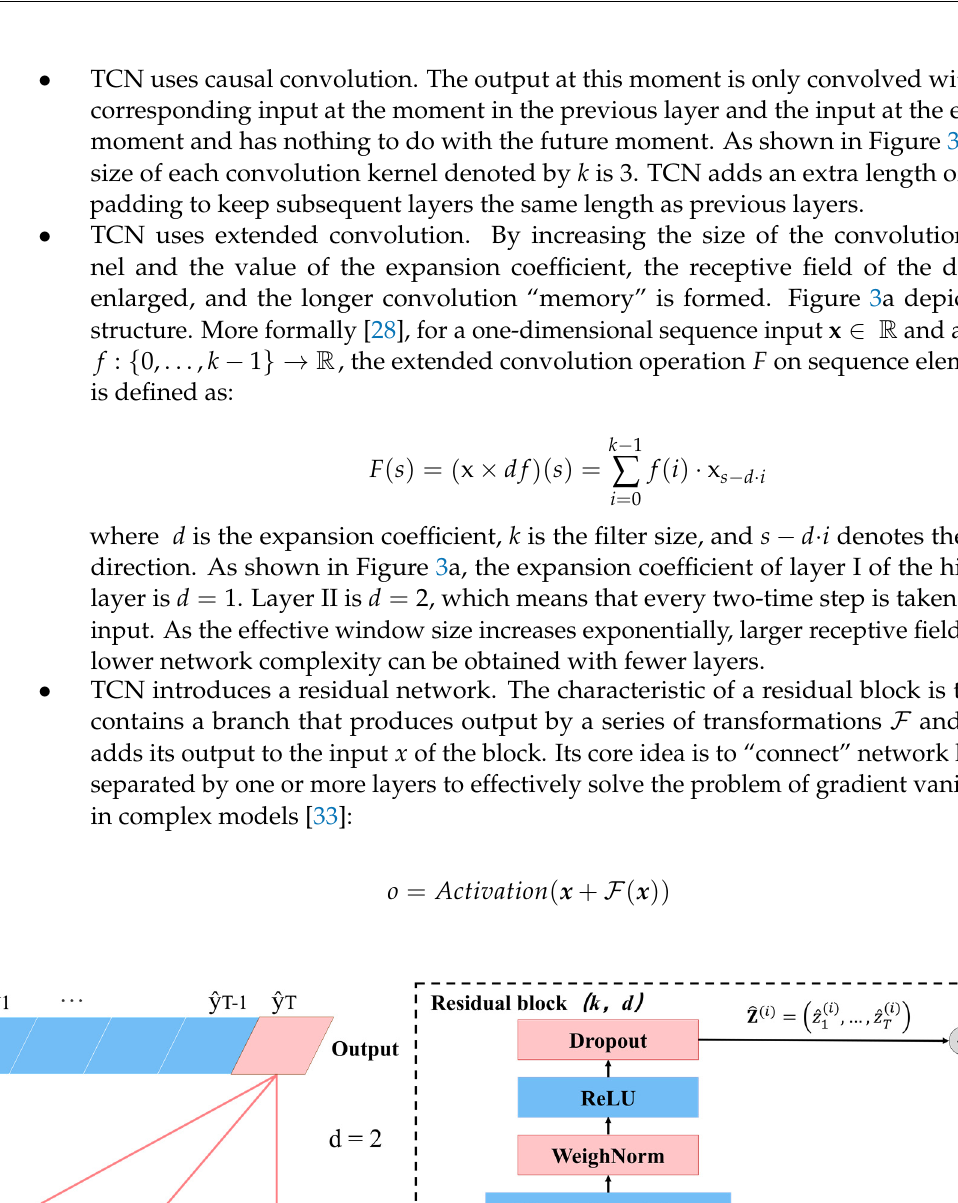
Figure 4. An example of residual connection in a TCN. An additional 1 × 1 convolution is added to ensure that the elements summing up receive tensors of the same shape. The red lines are filters in the residual function and the yellow lines are identity mappings. 3. Fusion TCN Layer. The fusion TCN layer model structure is similar to that of the channel TCN layer. The size of each convolution kernel is denoted by 𝑘 = 3 and